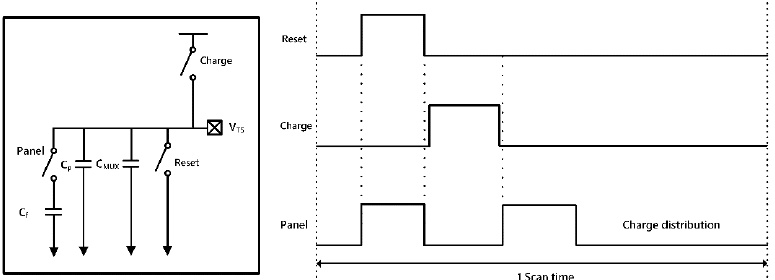
Figure 9. Timing diagram for data processing sequence.